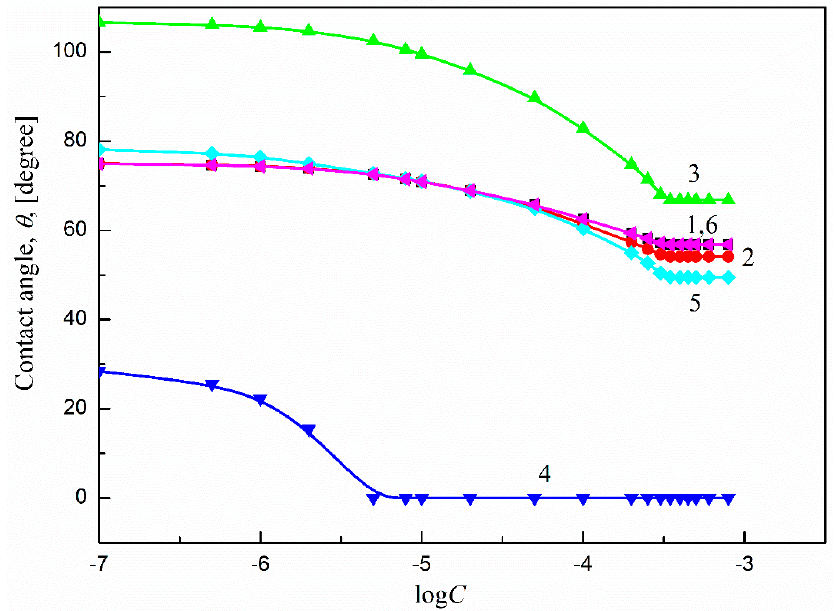
Figure 3. A plot of the contact angles ( θ ) of the aqueous solutions of SML on Ti6Al4V ELI. Curves 1 and 2—the θ values calculated from Equations (6) and (5), respectively; curves 3 and 4—the θ values calculated from Equation (3) assuming the orientations of tail (curve 3) and head (curve 4) of the surfactant towards the solid–water interface; curve 5—the θ values calculated from Equation (7) and curve 6—the measured θ values.